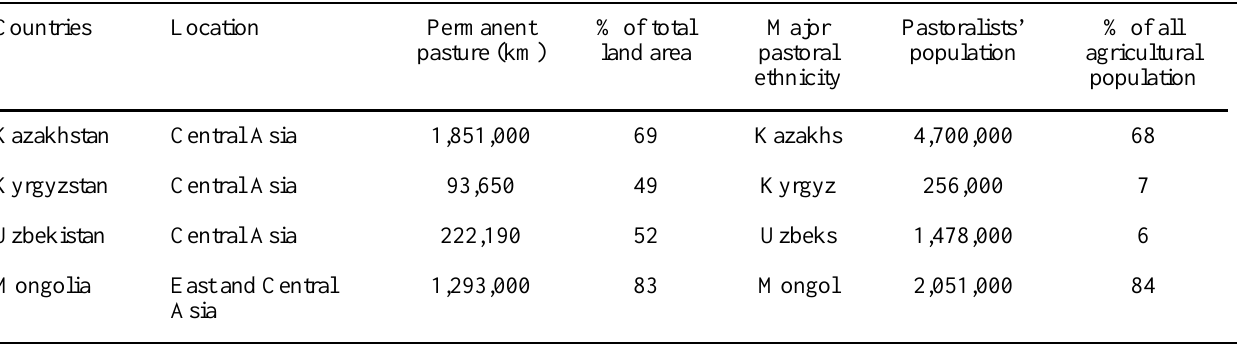
Table 2. Pastoral production in Kazakhstan, Kyrgyzstan, Uzbekistan, and Mongolia (FAO 1997, Thornton et al.